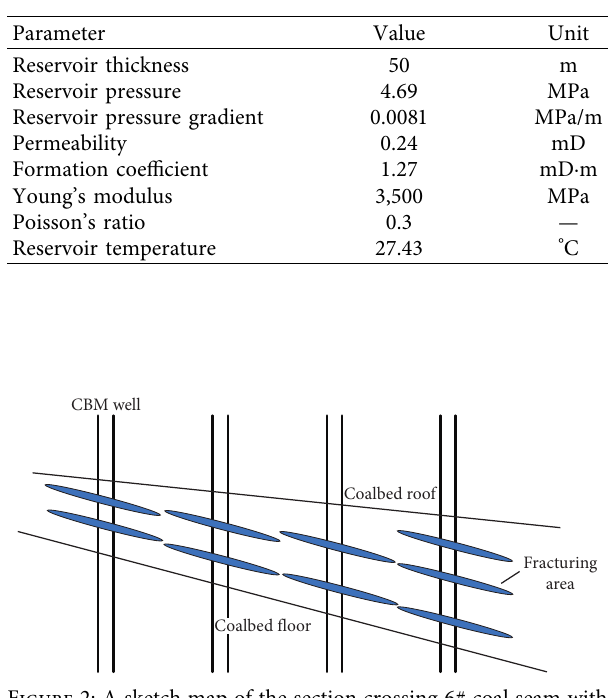
Figure 1: Distribution of CBM wells and pit in Shengli East No. 2 Open-Pit Coal Mine. Table 1: The input optimization parameters for Fracpro PT software simulation.